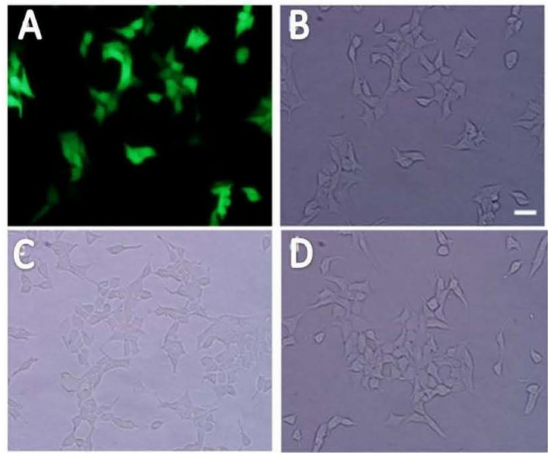
Figure 2. The morphology of transduced INS-1 cells. The transduced INS-1 cells showed strong green fluorescence ( A ) under a fluorescent microscope. The same view of the cells under white light field ( B ) show the cell morphology of transduced cells, indicating most of the cells were GFP-positive. From the view of morphology under the light microscope, the control un-transduced INS-1 cells ( C ) and InsR β KD INS-1 cells ( D ) were no much differences. The scale bar is 50 µ m and all images share the same